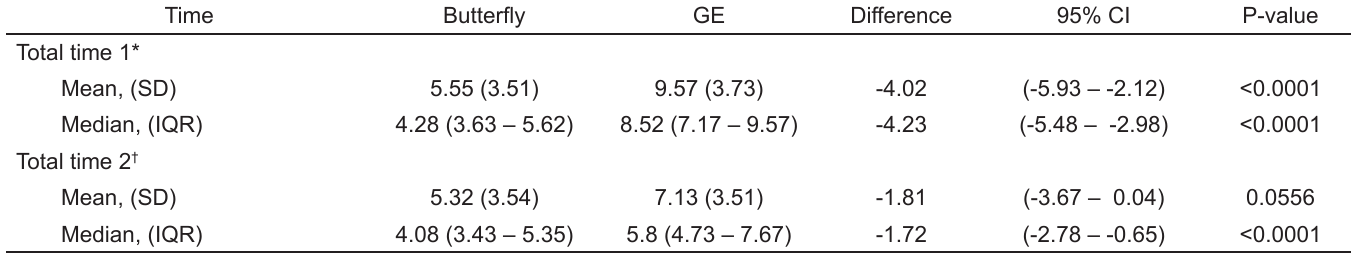
Table 1. Total time to complete ultrasound hypotension protocol,using handheld Butterfly vs cart-based GE devices.